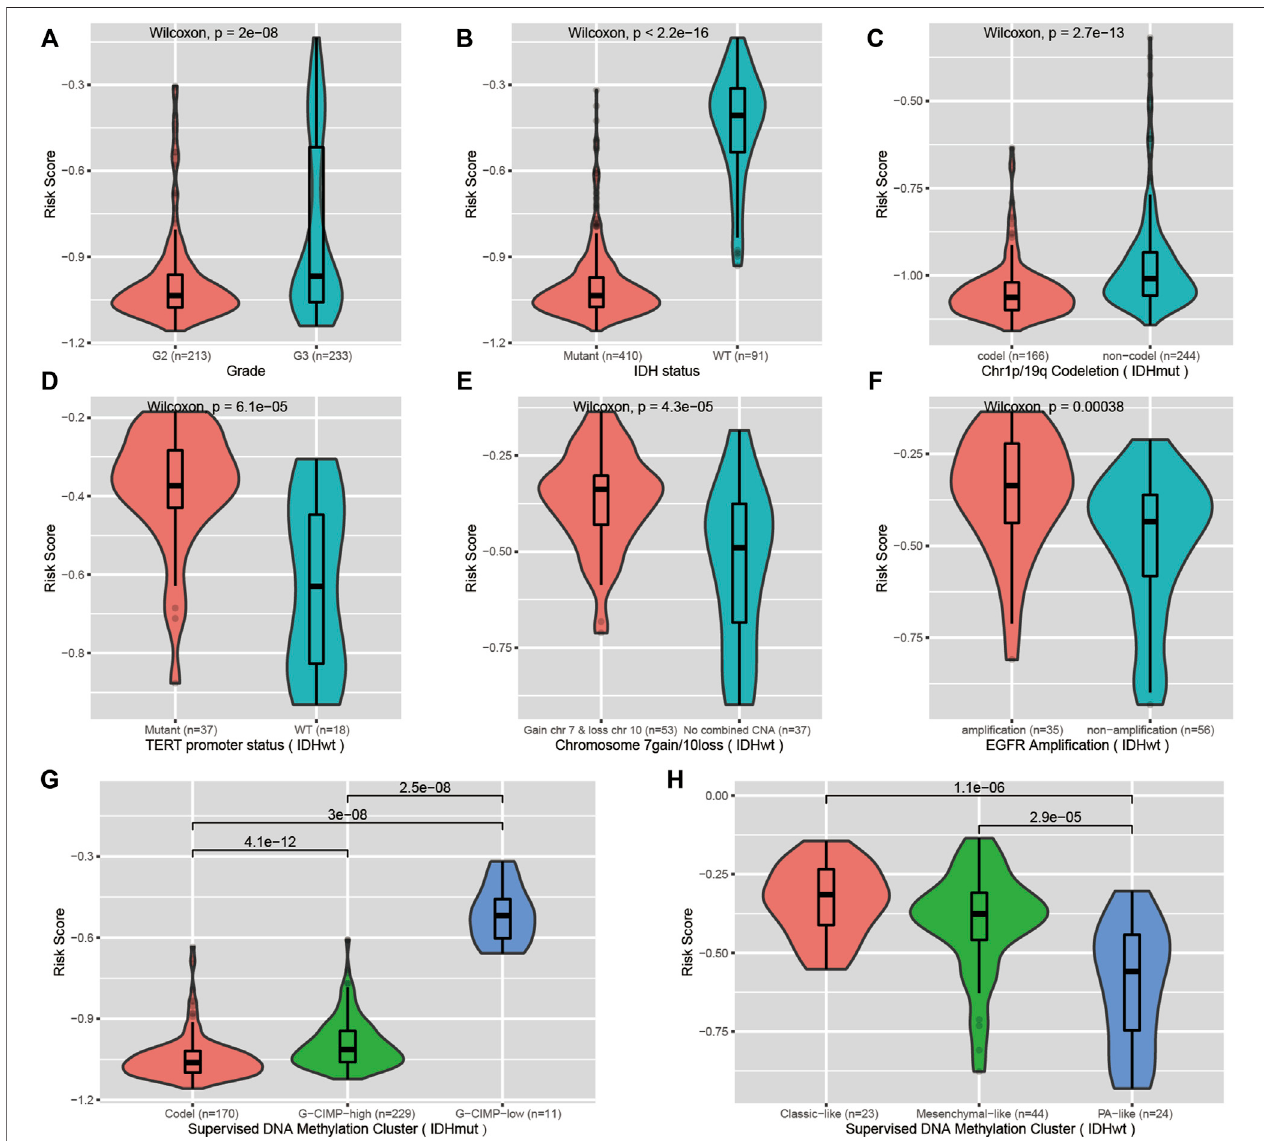
FIGURE 5 | Correlation of the CpG signature with common clinical features. (A,B) Distribution of the risk scores in LGGs strati fi ed by histological grade and IDH mutation status. (C,G) Distribution of the risk scores in IDH-mutant LGGs strati fi ed by chromosome 1p/19q codeletion status and supervised DNA methylation cluster. (D – F,H) Distribution of the risk scores in IDH wild-type LGGs strati fi ed by TERT promoter status, chromosome 7gain/10loss, EGFR ampli fi cation and supervised DNA methylation cluster.